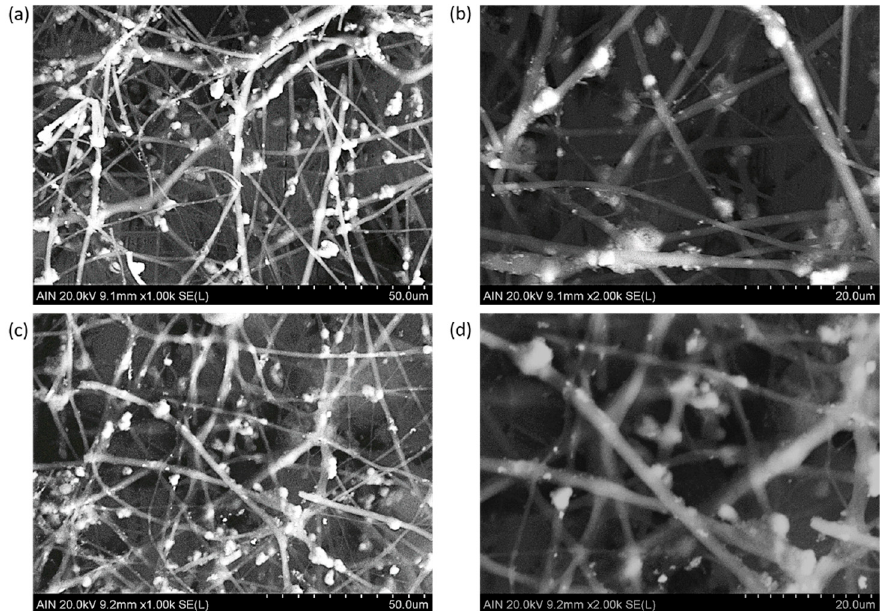
Figure 8. SEM images of the samples composed of PAA + β -CD + TiO 2 fibers ( a , b ) and PAA + β -CD + TiO 2 + Fe 2 O 3 ( c , d ) fibers at different scale bars of 50 µm ( a , c ) and 20 µm ( b , d ).